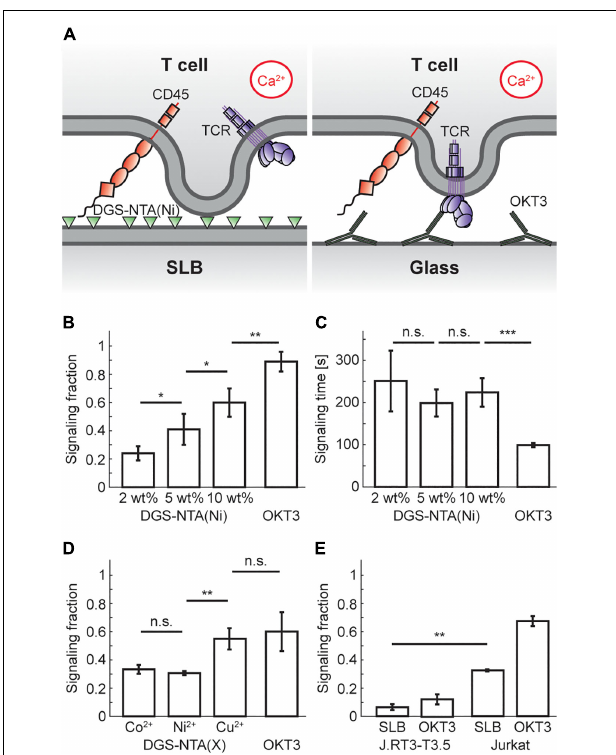
FIGURE 1 | T-cell signaling fraction increases with concentration of DGS-NTA(Ni) in the SLB. (A) Schematic illustration showing calcium signaling by either ( left ) DGS-NTA(Ni) in an SLB or ( right ) anti-CD3 antibodies on glass. (B) The fraction of signaling T cells for either ligand-free SLBs with DGS-NTA(Ni) or OKT3 on a glass slide (mean signaling fraction ± s.d.). (C) The time between cell landing and calcium signaling for either ligand-free SLBs with DGS-NTA(Ni) or OKT3 on a glass slide (mean signaling time ± s.d.). (D) The signaling fraction binding to a ligand-free SLB containing 5 wt% DGS-NTA(X), with X being either Co 2 + , Ni 2 + or Cu 2 + . (E) The signaling fraction of J.RT3-T3.5 cells ( left ) and Jurkat T cells ( right ) on SLBs with ligand-free 5 wt% DGS-NTA(Ni) and on OKT3-coated glass. Data are shown for three to five experiments, except for E which is from two experiments, with 150 cells in each experiment. A two-sample t -test in MATLAB was used for statistical analysis with: * < 0.05, ** < 0.01, *** <